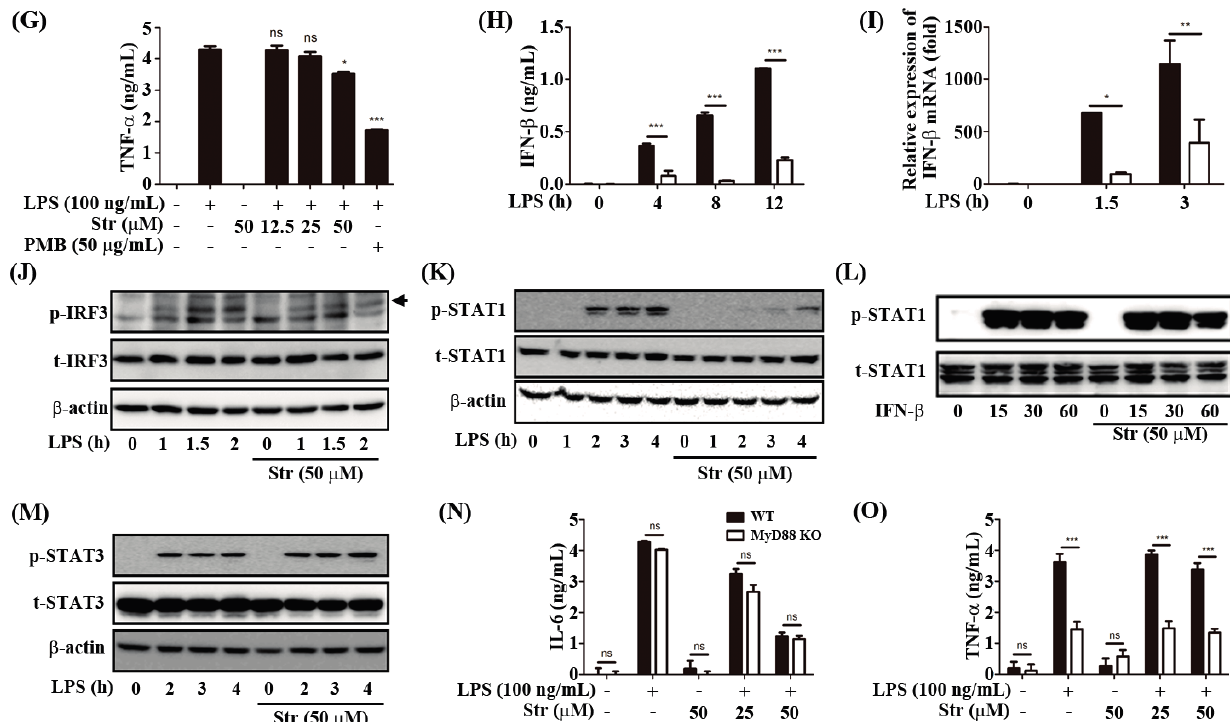
Figure 1. Effect of streptochlorin on the production of inflammatory mediators in lipopolysaccharide (LPS)-stimulated RAW264.7 cells. RAW264.7 cells were pretreated with streptochlorin (Str) at indicated concentration for 1 h and then treated with LPS (100 ng/mL). After incubation for 24 h, ( A ) the nitrite level in the culture supernatant was measured using nitric oxide (NO) assay; ( B ) The level of inducible nitric oxide synthase (iNOS) and cyclooxygenase-2 (COX-2) after 18 h of incubation was determined by western blot; Both protein ( C ) and mRNA level ( D ) of pro-IL-1 β after 4 h and indicated time incubation, IL-6 ( E , F ) after 16 h and indicated time incubation, tumor necrosis factor α (TNF- α ) ( G ) after 4 h of incubation, and IFN- β ( H , I ) after indicated time incubation was determined by western blot analysis, enzyme-linked immunosorbent assay (ELISA), and real-time polymerase chain reaction (PCR). After indicated time of incubation, phosphorylation of IRF3 ( J ), signal transduction and activation of transcription 1 (STAT1) ( K ), and STAT3 ( M ) was determined by western blot analysis. RAW264.7 cells were pretreated with streptochlorin at 50 μ M for 1 h and then treated with IFN- β (100 U/mL); ( L ) After indicated incubation time, phosphorylation of STAT1 was determined by western blot analysis. Wild type (WT) and MyD88 knockout (Myd88 KO) mice-originated peritoneal macrophages were pretreated with LPS. After incubation for 16 and 3 h, the protein level of IL-6 ( N ) and TNF- α ( O ) was determined by ELISA. The results are expressed as mean ± SEM ( n = 3). * p < 0.05, ** p < 0.01, and *** p < 0.001 compared with LPS-treated cells. n.s.: none